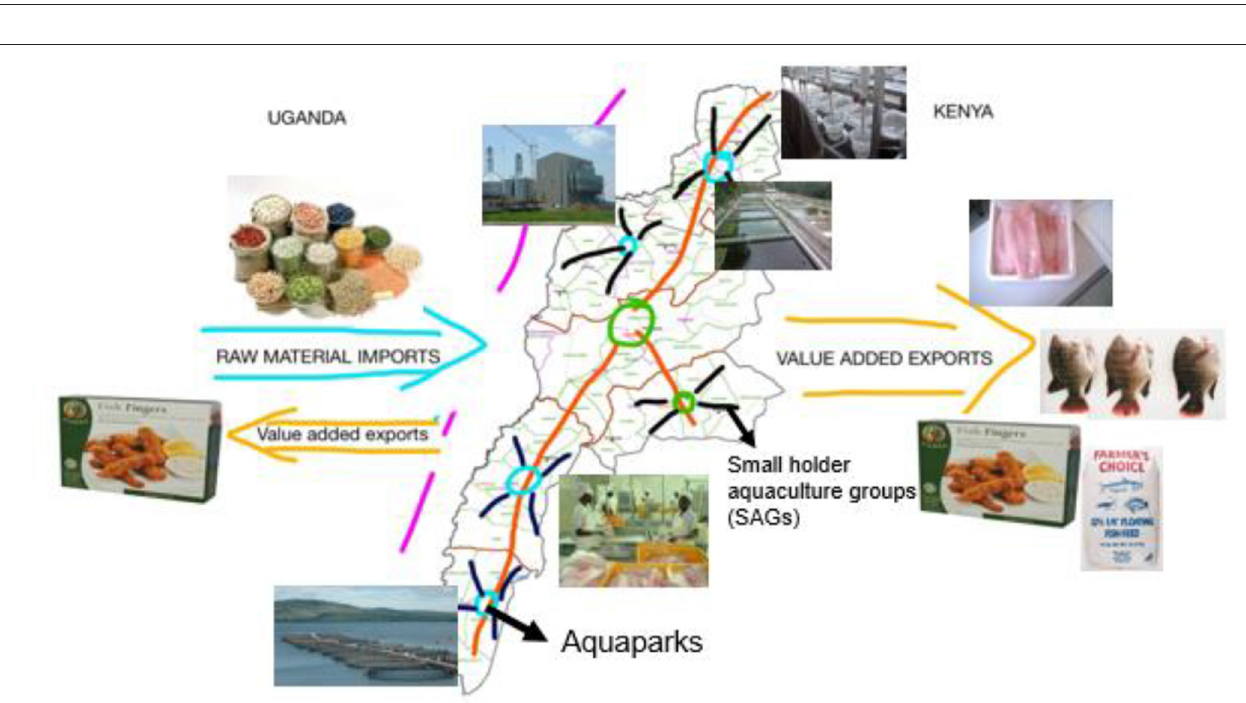
FIGURE 6 | Busia County Aquaculture production, marketing, and input distribution